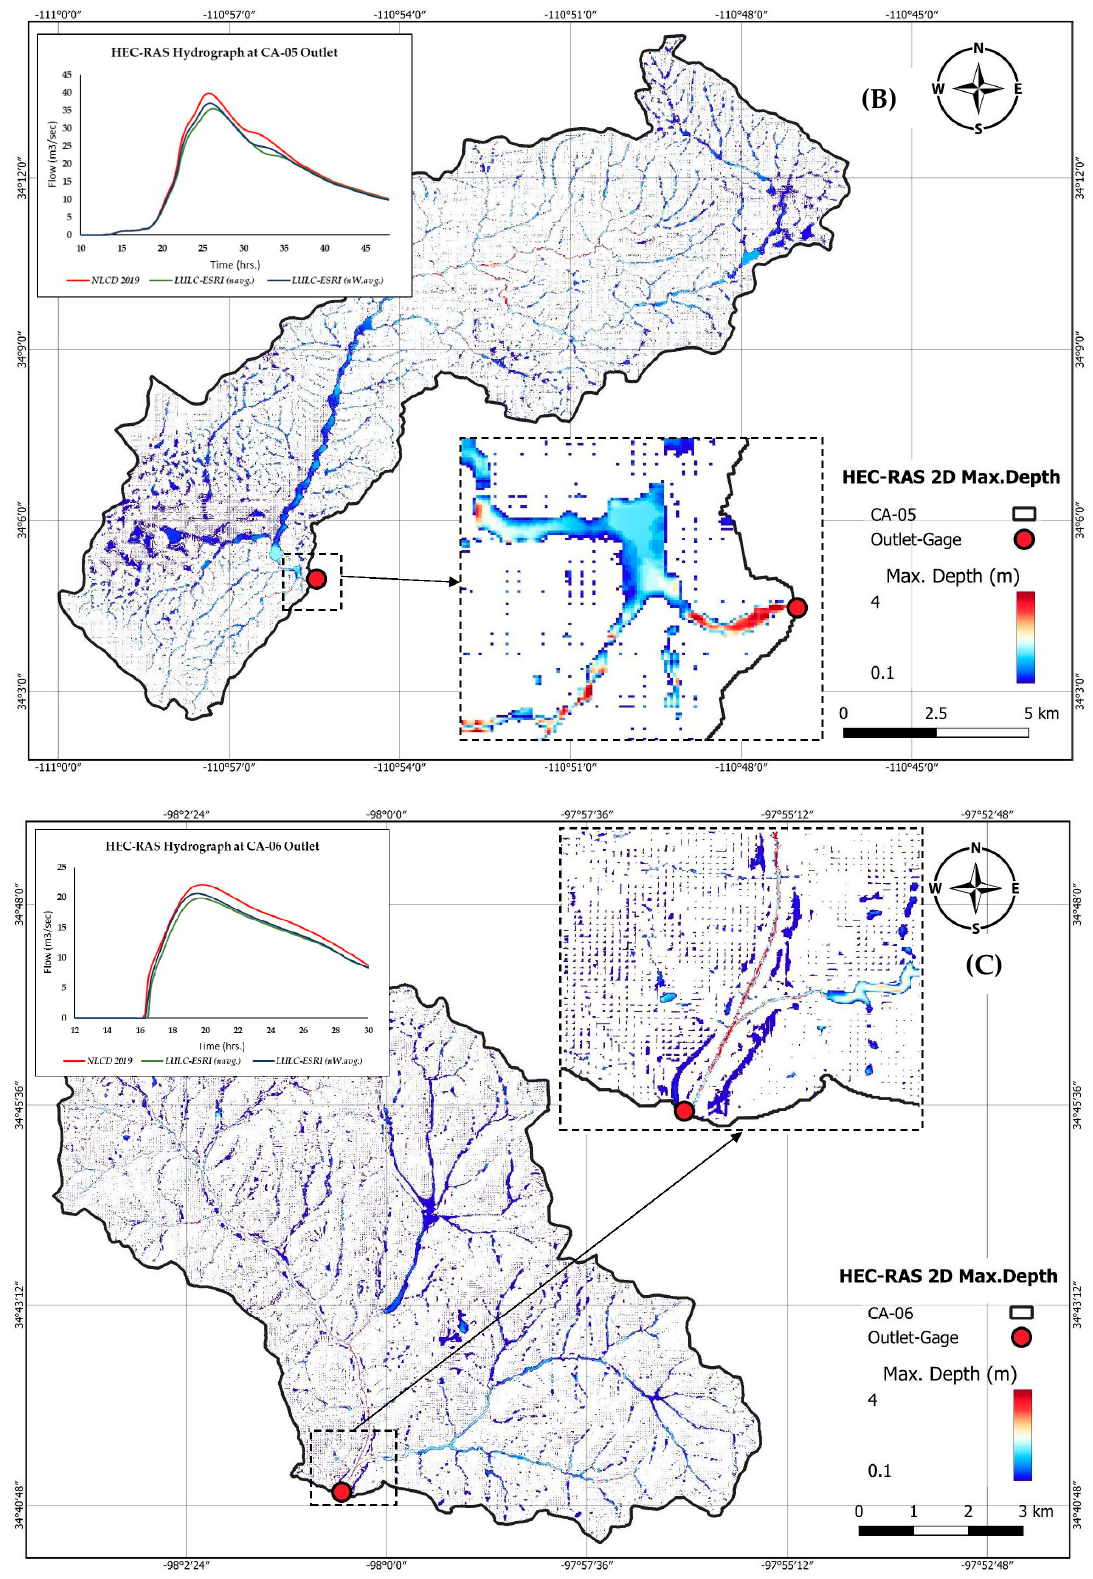
Figure A11. HEC-RAS 2D calibration results, maximum depth, hydrograph at outlet ( A ) Catchment CA-04, ( B ) Catchment CA-05, ( C ) Catchment CA-06.